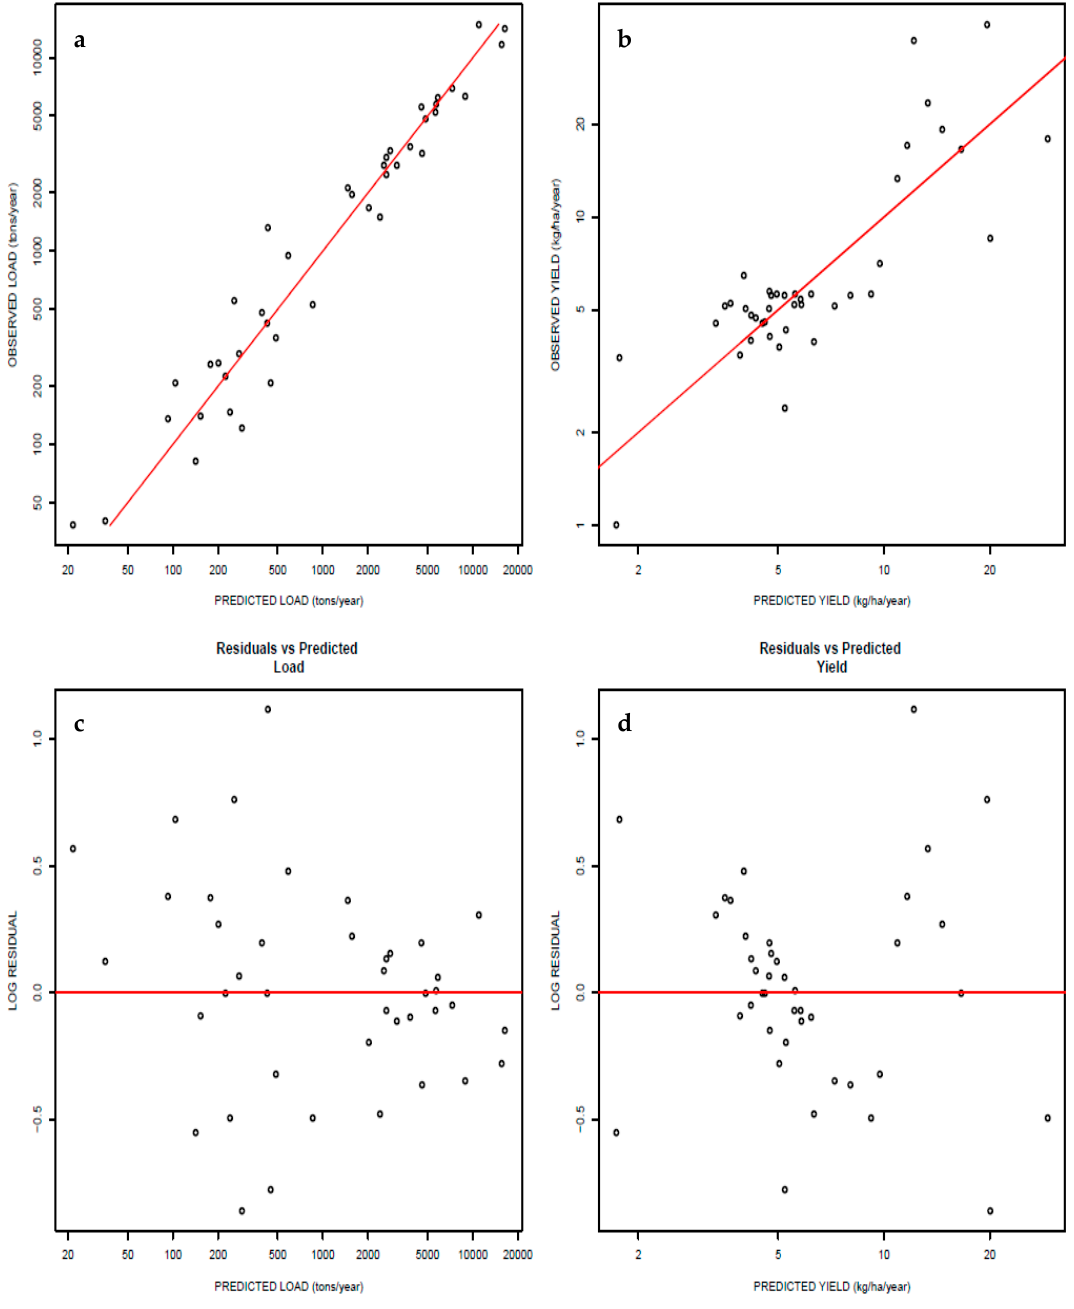
Figure 2. Model diagnostic plots showing ( a ) observed versus predicted loads, ( b ) observed versus predicted yields, ( c ) log residuals versus predicted loads, and ( d ) log residuals versus predicted yields for conditioned predictions.